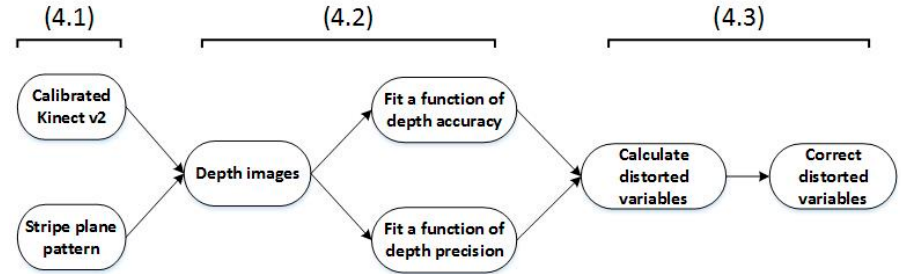
Figure 3. The post-rectification approach overview.